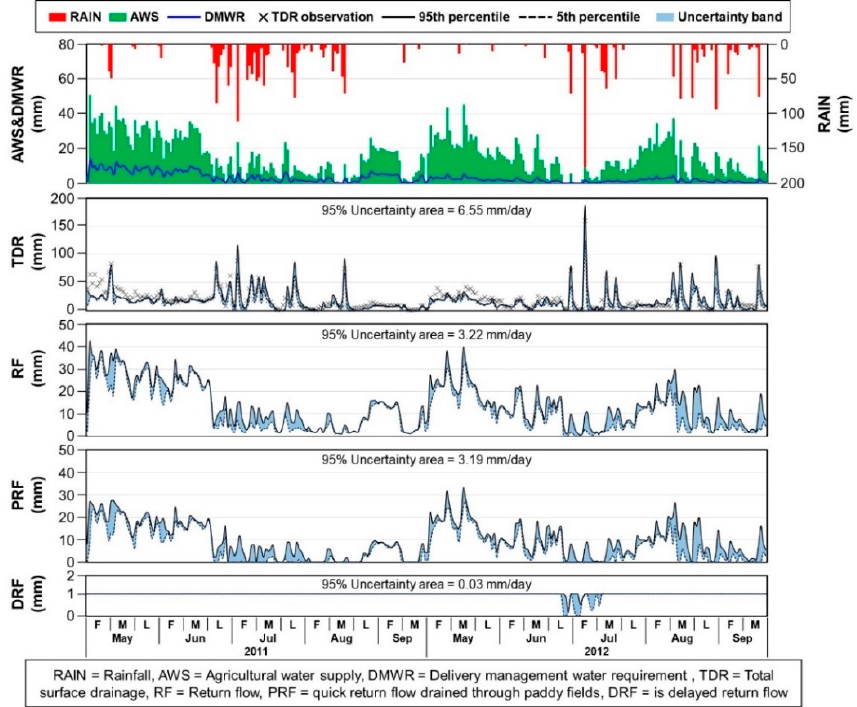
Figure 7. Temporal variations of inputs ( RAIN and AWS ), outputs ( DMWR , TDR , RF , PRF , and DRF ), and uncertainty (the 95% confidence interval) of output modeling using the PHY approach. Simulated TDR is compared with the observations.